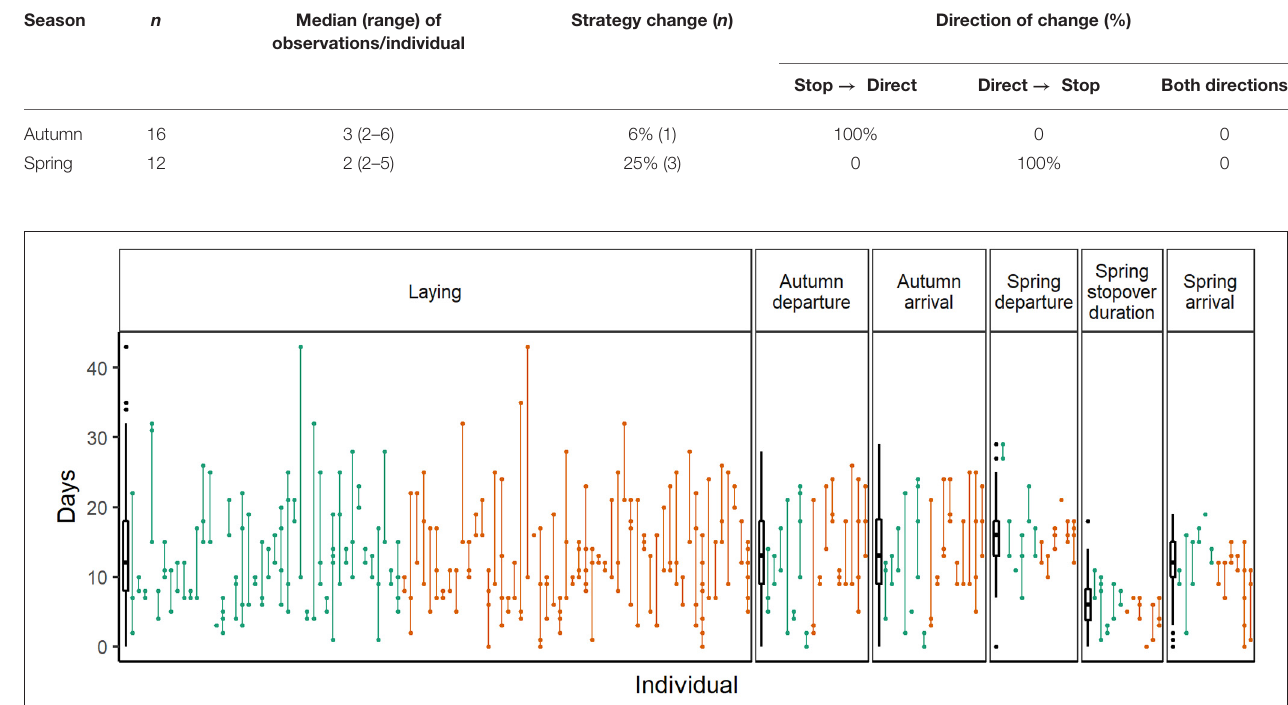
FIGURE 2 | Population and individual interannual variation at each stage of the annual cycle for female (green) and male (orange) Icelandic whimbrels. Population data are summarized by the boxplot on the left of each panel (showing the median and 25 and 75% quartiles, whiskers extending up to 1.5 times the inter quartile range from the median and points beyond that are individually marked) and aims to serve as a reference to visually compare individual variation. Each data point shows the timing or duration of the event in a given year and all observations of the same individual are linked with a vertical line; dates were standardized by subtracting the minimum value observed for each stage at the population level. Note that at spring departure one individual left the wintering area considerably early (shown as an outlier), creating and apparent large variation at this stage if only the boxplot (population) is considered; the same individual then performed the longest stopover recorded (upper outlier). Unfortunately, we do not have repeated tracks of this individual to explore consistency in these stages, as it did not return to the breeding sites after the geolocator was